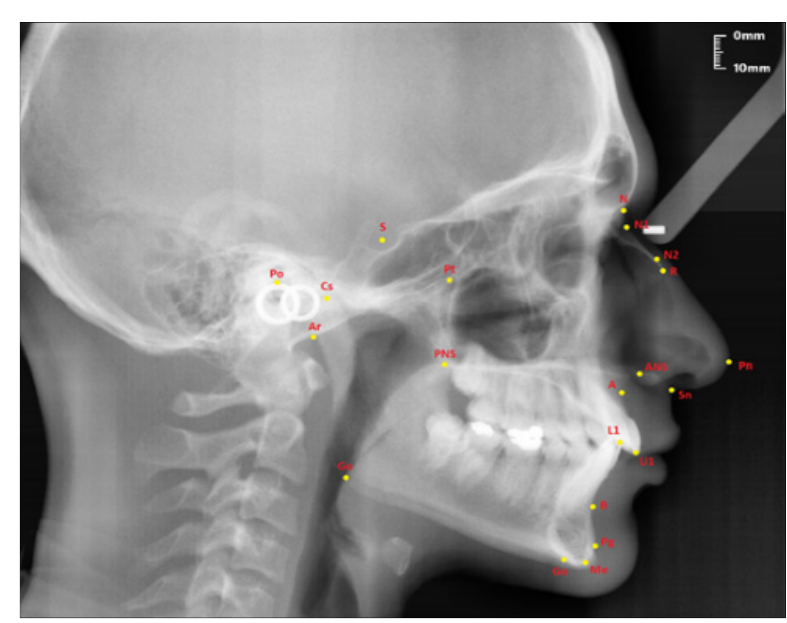
Figure 1. Points used in the study.